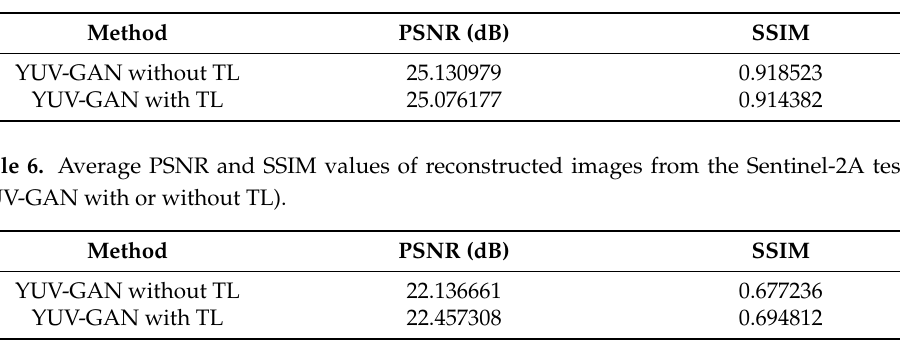
Table 5. Average PSNR and SSIM values of reconstructed images from the RICE1 test set (YUV-GAN with or without TL).